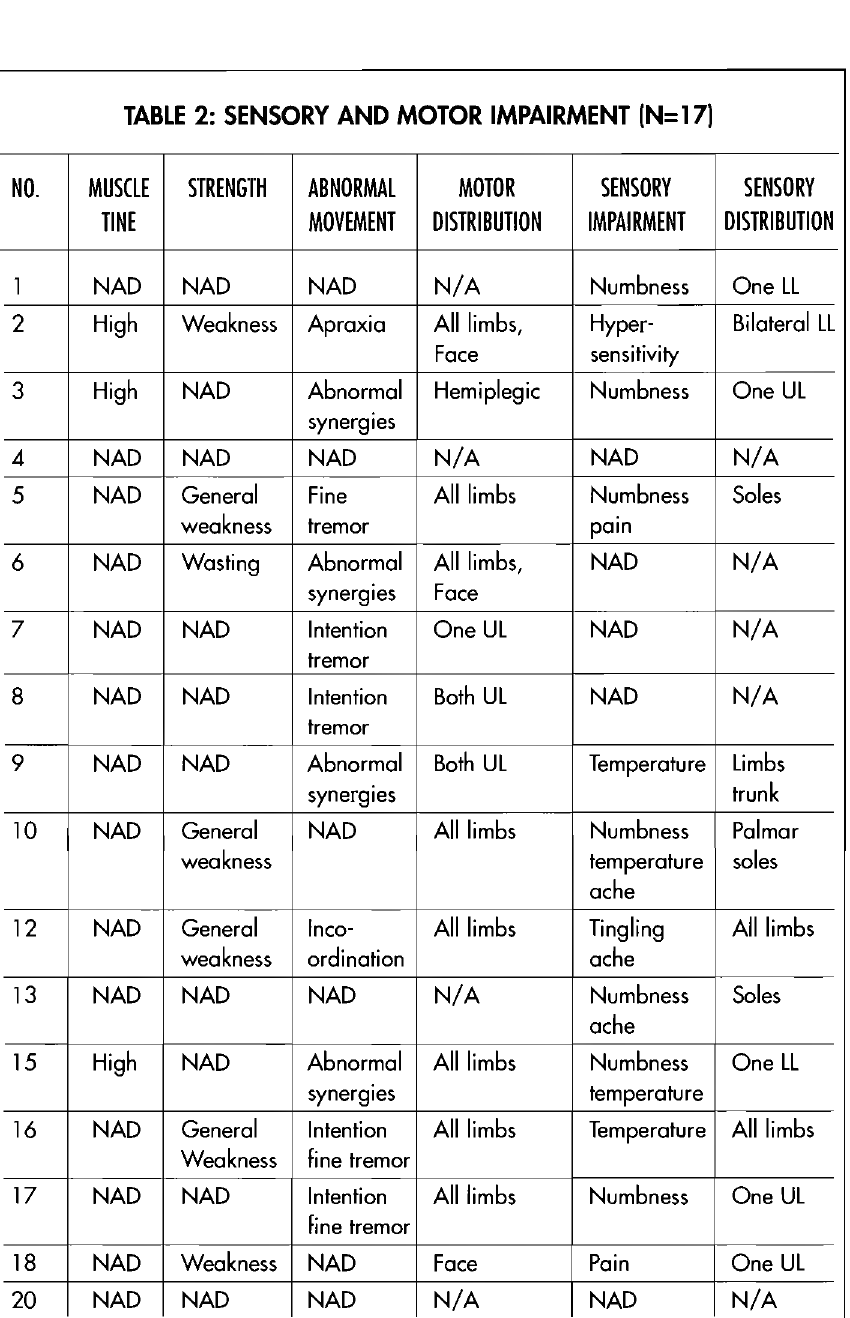
TABLE 2: SENSORY AND MOTOR IMPAIRMENT